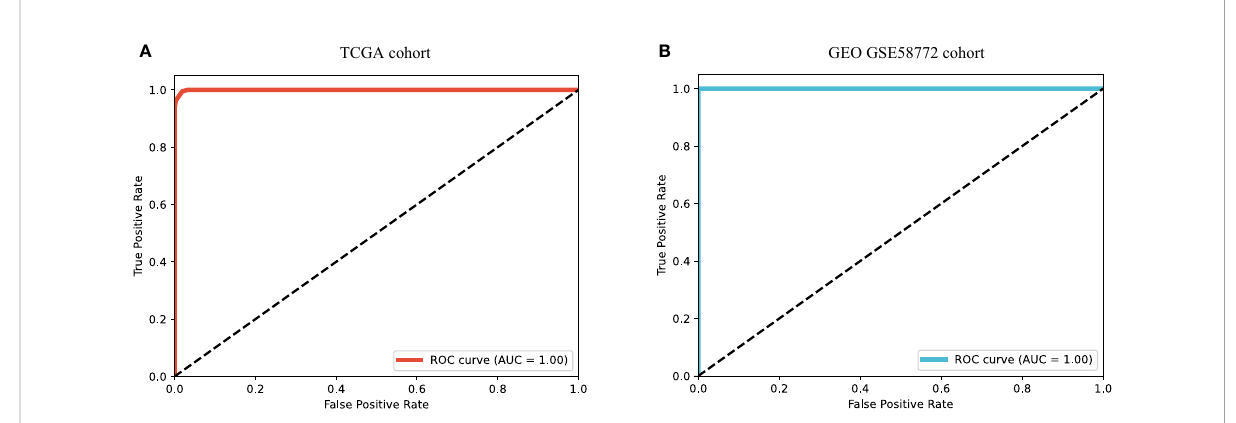
FIGURE 4 RCO curves of MLP model for histologic subtype prediction using transcriptional pattern. (A) ROC curve on TCGA cohort. (B) ROC curve on GEO GSE58772 cohort.